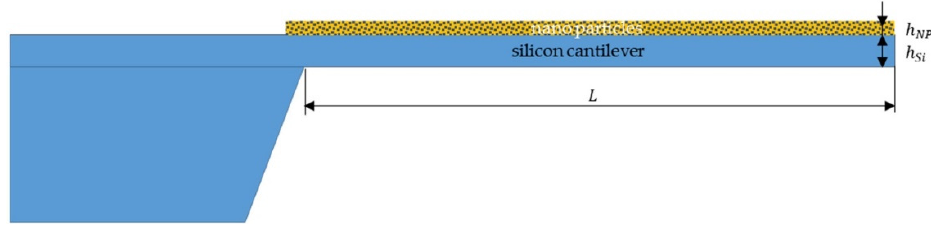
Figure A1. Cantilever model used in this study.